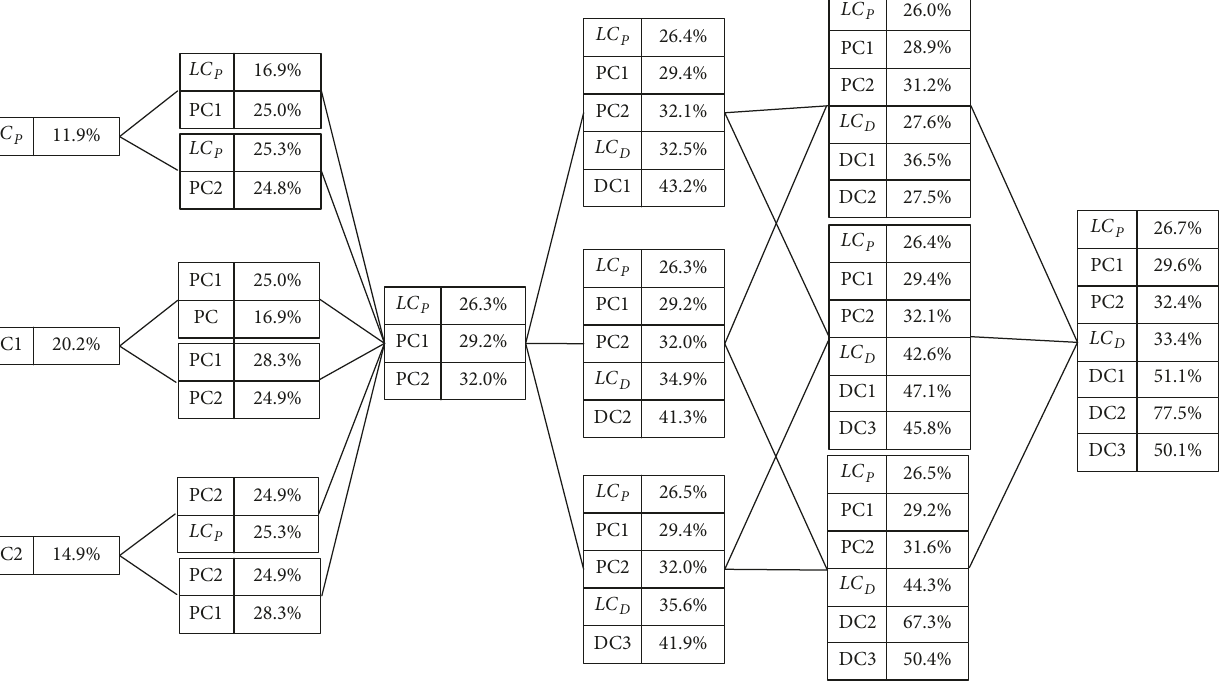
Figure 5: Grand alliance formation process.